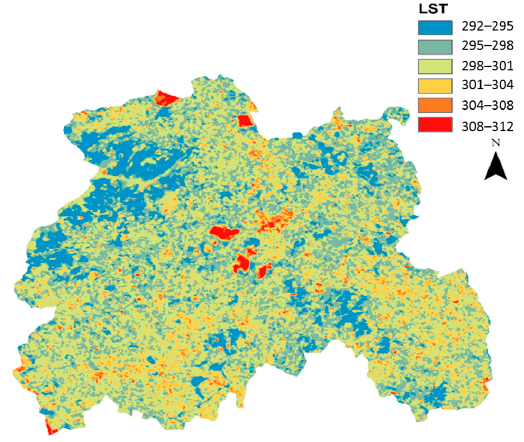
Figure 4. LST map (K) (17 July 2006).